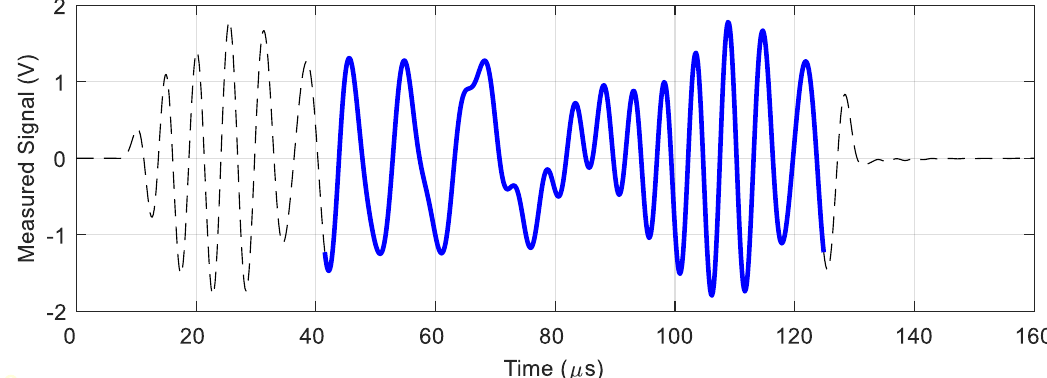
Figure 5. The measured signal on the pickup coil. The blue line marks the signal segment that is subject to further analysis.